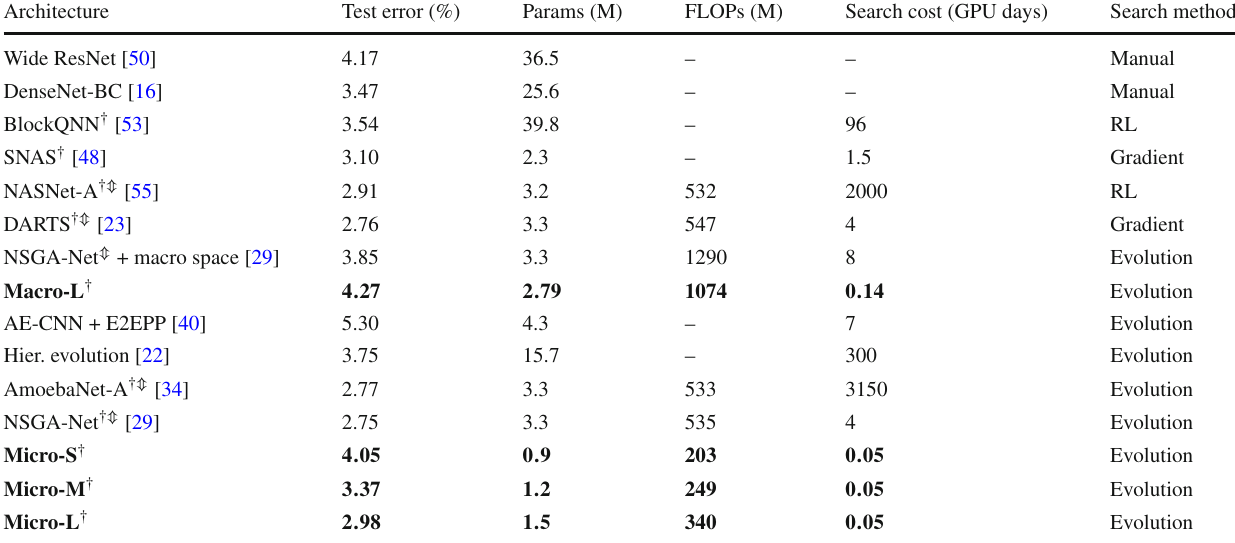
Table 1 The results of the proposed algorithm and other state-of-the-art methods on CIFAR-10 Architecture